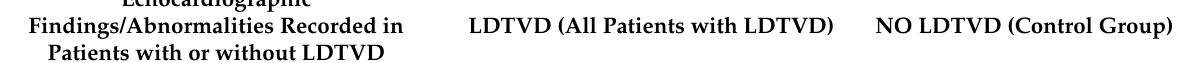
Table 5. Echocardiographic findings/abnormalities. Classification according to the